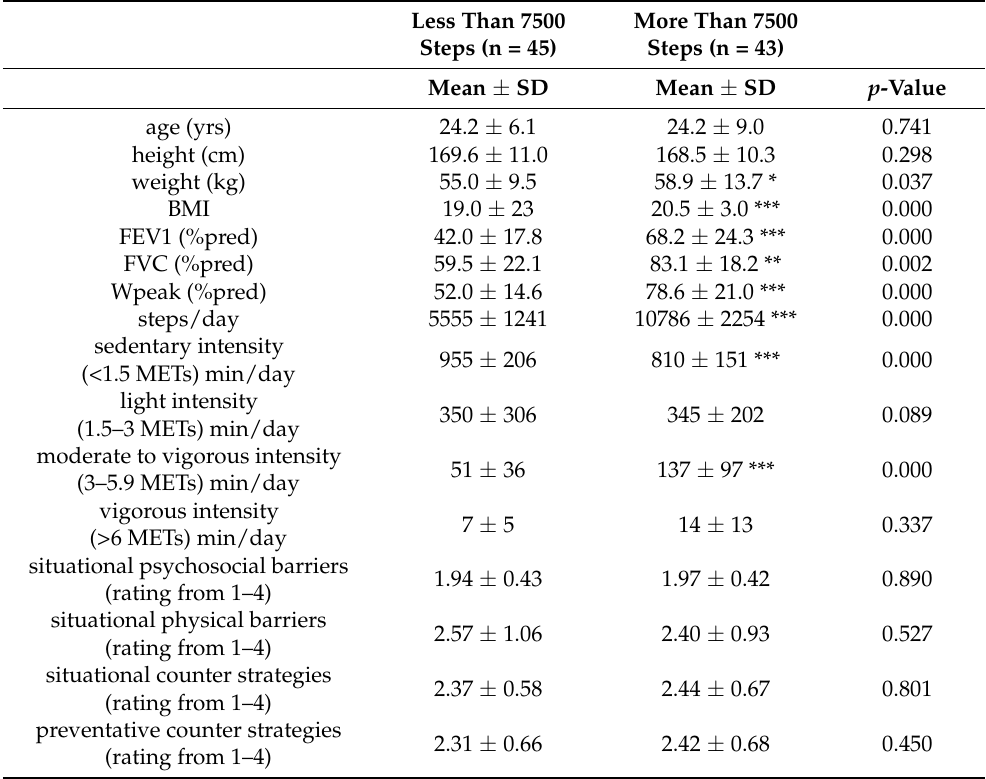
Table 2. Anthropometric characteristics, lung function and steps/day, and intensity of physical exercise of participants by steps less than 7500 and more than 7500 steps at